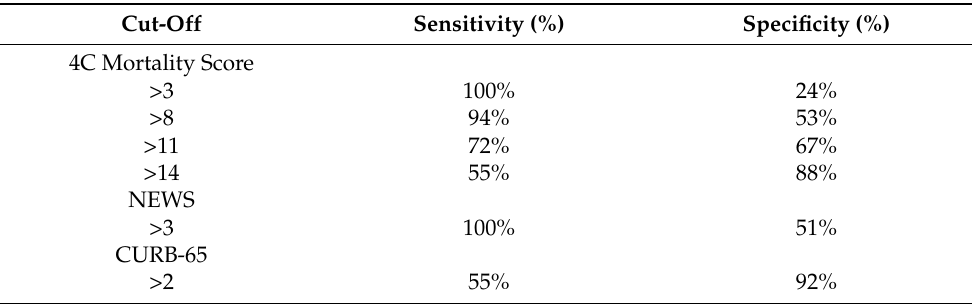
Table 4. Diagnostic accuracy measures for mortality prediction at cut-offs of the 4C Mortality Score, NEWS, and CURB-65.